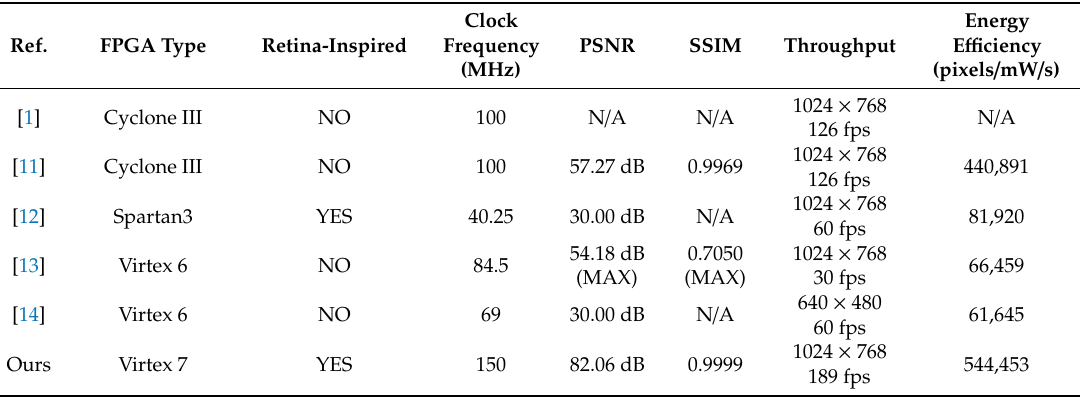
Table 4. Comparison with other tone mapping